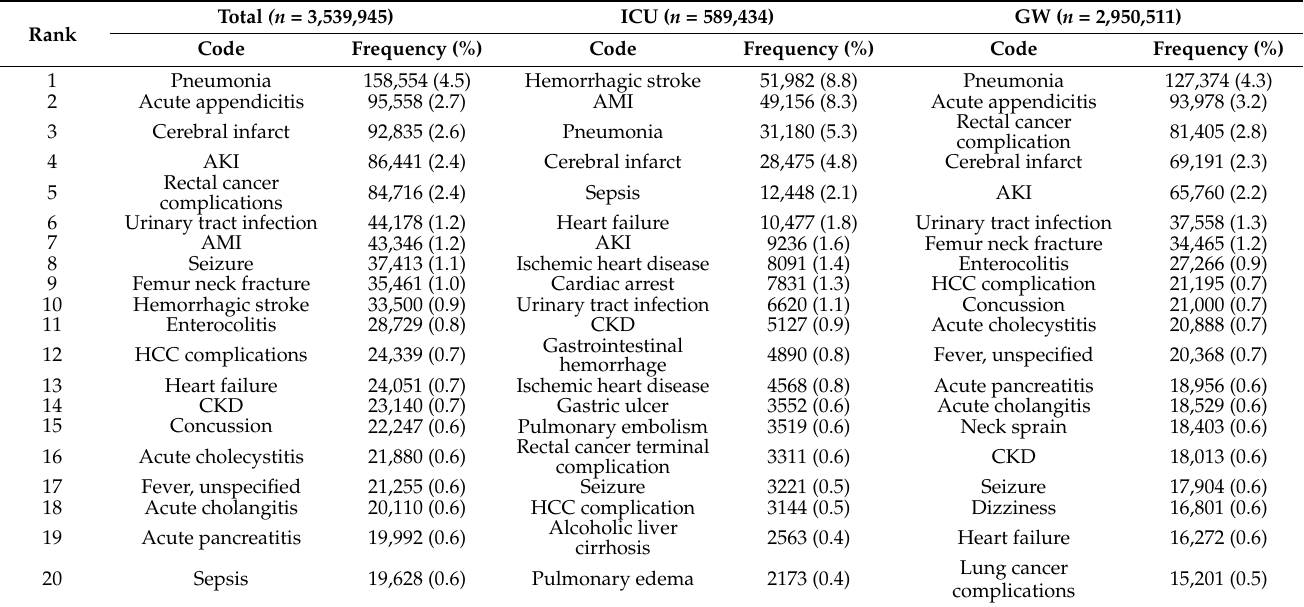
Table 3. Top 20 common diagnoses of admitted patients.